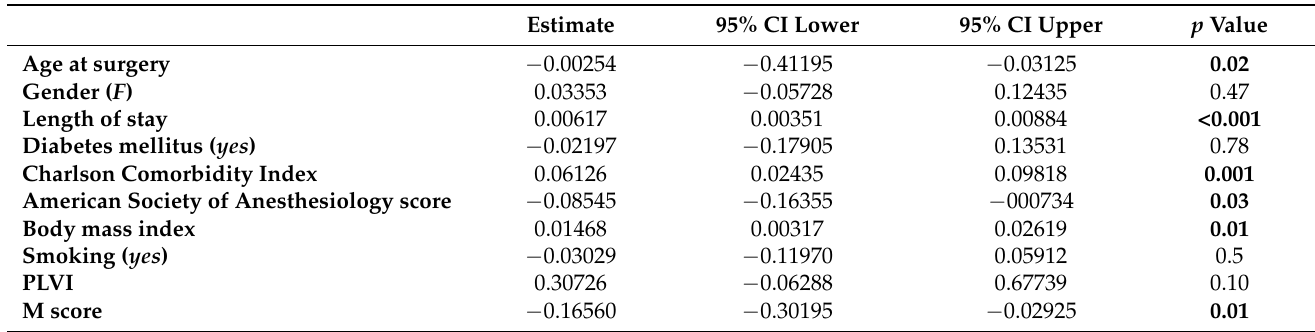
Table 2. Multivariate linear regression of risk factors for infection. F = female, PVLI = psoas to lumbar vertebral index. Length of stay, age, comorbidity index, ASA score and M score were independent risk factors for infection.